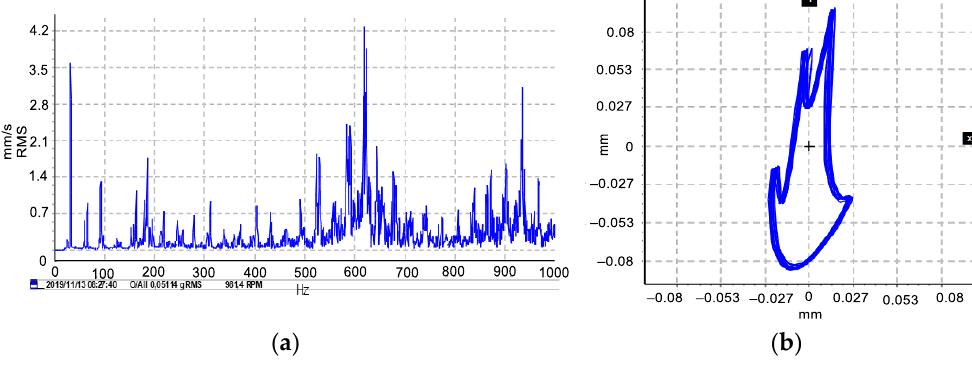
Figure 8. Rotor-stator contact: ( a ) Frequency response; ( b ) rotor orbit.